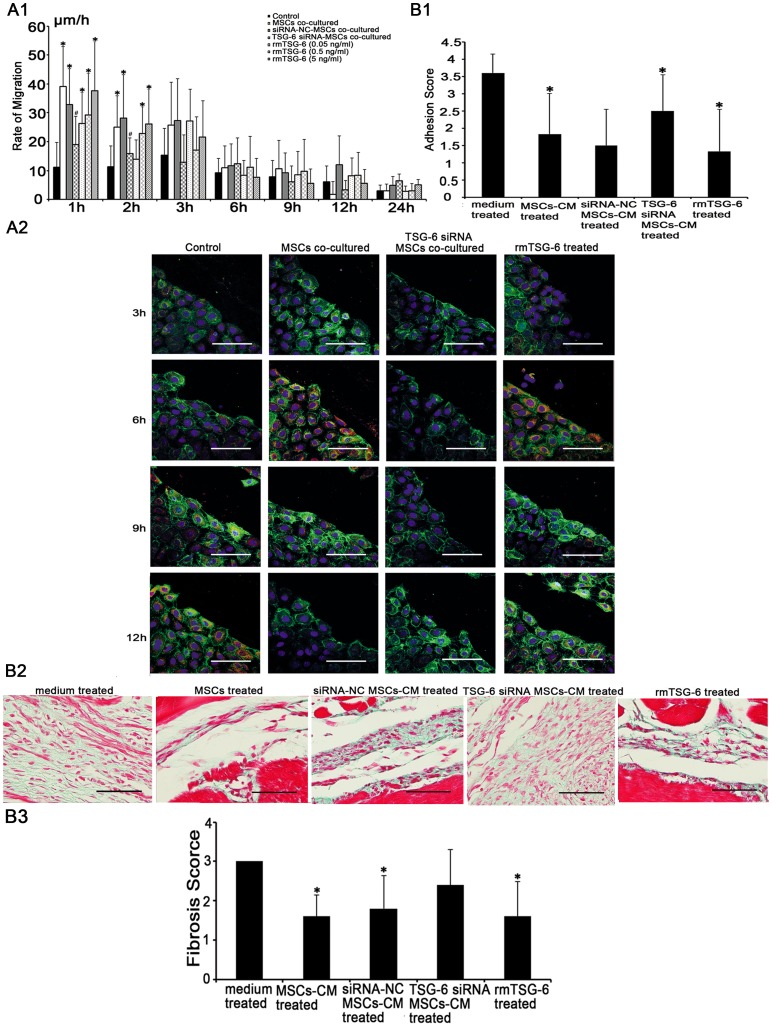
TNF-stimulating gene (TSG)-6 secreted by mesenchymal stem cells (MSCs) ameliorated the peritoneal injury.(A). The effects of TSG-6 on the repair of mechanically injured rat peritoneal mesothelial cells (RPMCs). (A1). Microscopy of RPMCs migrating to the edge of the wound to show the migratory velocity (μm/h). Injured RPMCs co-cultured with TSG-6-siRNA MSCs showed significant reductions in the migratory capacity. However, migrations were significantly increased dose-dependently in RPMCs cultured in medium containing recombinant mouse (rm) TSG-6. * compared with control group, p <0.05; # compared with MSCs co-cultured group, p <0.05; n  = 3, respectively. (A2). Immunofluorescence analysis with PCNA (red) and E-Cadherin (green) revealed the proliferation of injured RPMCs. RPMCs co-cultured with TSG-6-siRNA MSCs showed no apparent increase in the proliferative capacity. whereas the proliferation peak of RPMCs cultured with rmTSG-6 was accelerated to 6 h after scraping. Nuclei were stained with DAPI (blue). Magnification  = ×600. (B). The effects of TSG-6 on acute peritoneal adhesions. (B1). TSG-6-siRNA MSCs-CM treated group had no significant reduction in adhesion scores days 14 after scraping. However, adhesion scores were reduced in rmTSG-6 treated group. The size and severity of peritoneal adhesions were evaluated macroscopically by an independent observer on a scale of 0–4 (0, 0%; 1, <25%; 2, 25–49%; 3, 50–74%; and 4, 75–100% adhesions). * compared with medium treated group, p <0.05, n  = 6, respectively. (B2). Histological changes were evaluated using masson's trichrome staining. TSG-6-siRNA MSCs-CM treated group revealed no apparent reduction in fibrosis in the scraped peritoneum days 14 after scraping. However, fibrosis were reduced in rmTSG-6 treated group. Magnification  = ×400. (B3). The scores of peritoneal fibrosis days 14 after scraping were reduced by injecting rmTSG-6, but not by injecting TSG-6-siRNA MSCs-CM. * compared with medium treated group, p <0.05, n  = 6, respectively. The sections were evaluated from five randomly selected fields under a magnification of ×100 by an independent pathologist. The extent of fibrosis was scored as 0 (negative), 1 (weak), 2 (medium), or 3 (intensive).